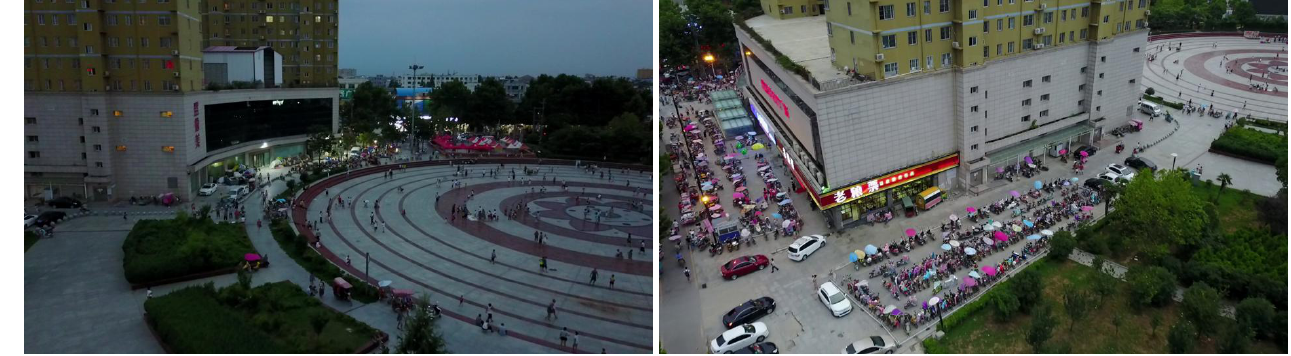
Figure 1. Intuitive cases about the main problems in object detection on drone-captured